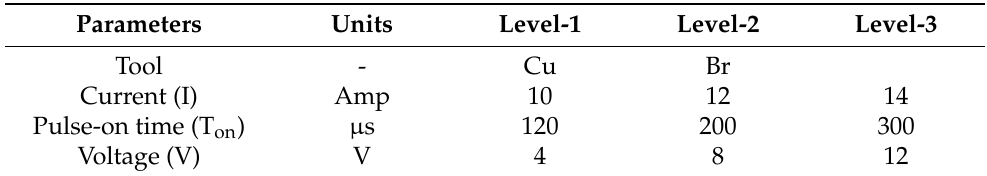
Figure 2. Pictorial views of samples and electrodes. Table 3. Selected EDM process parameters and their